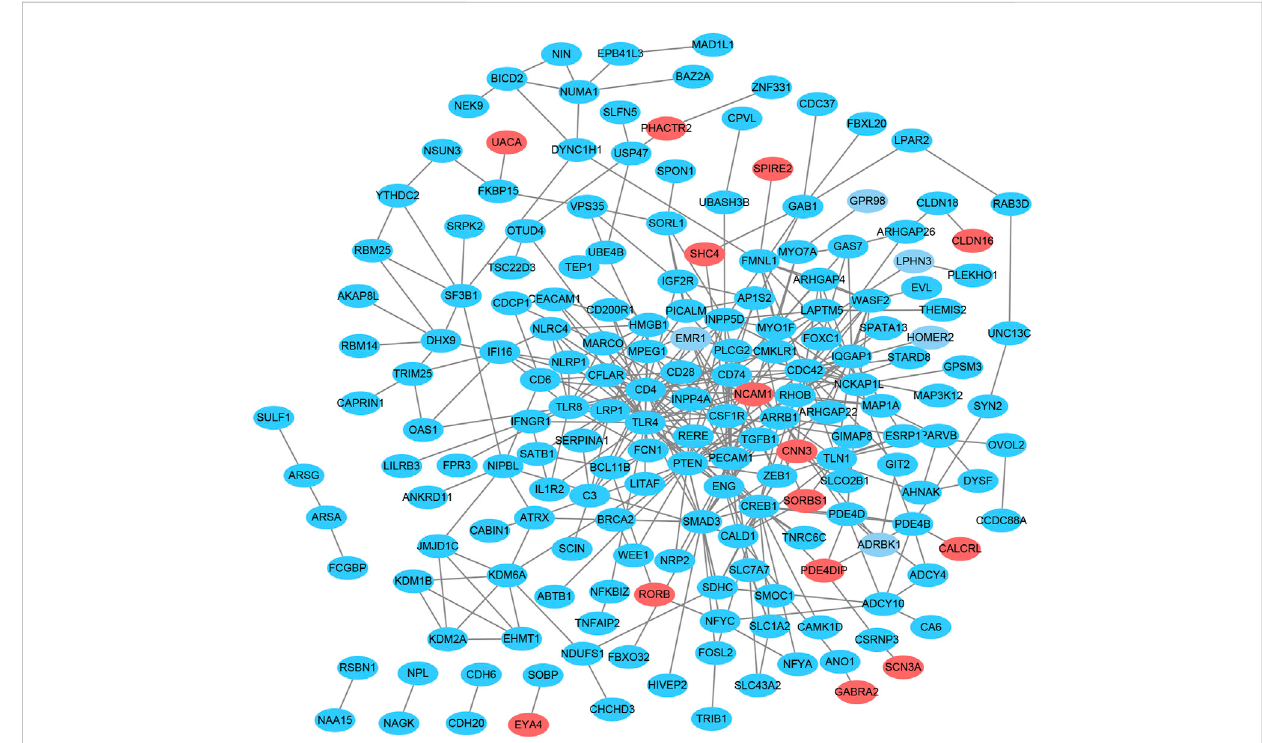
FIGURE 4 Protein-protein interaction network analysis of the overlapping genes. The PPI network consists of 265 nodes and 389 edges. Red indicates upregulation, and blue indicates downregulation.